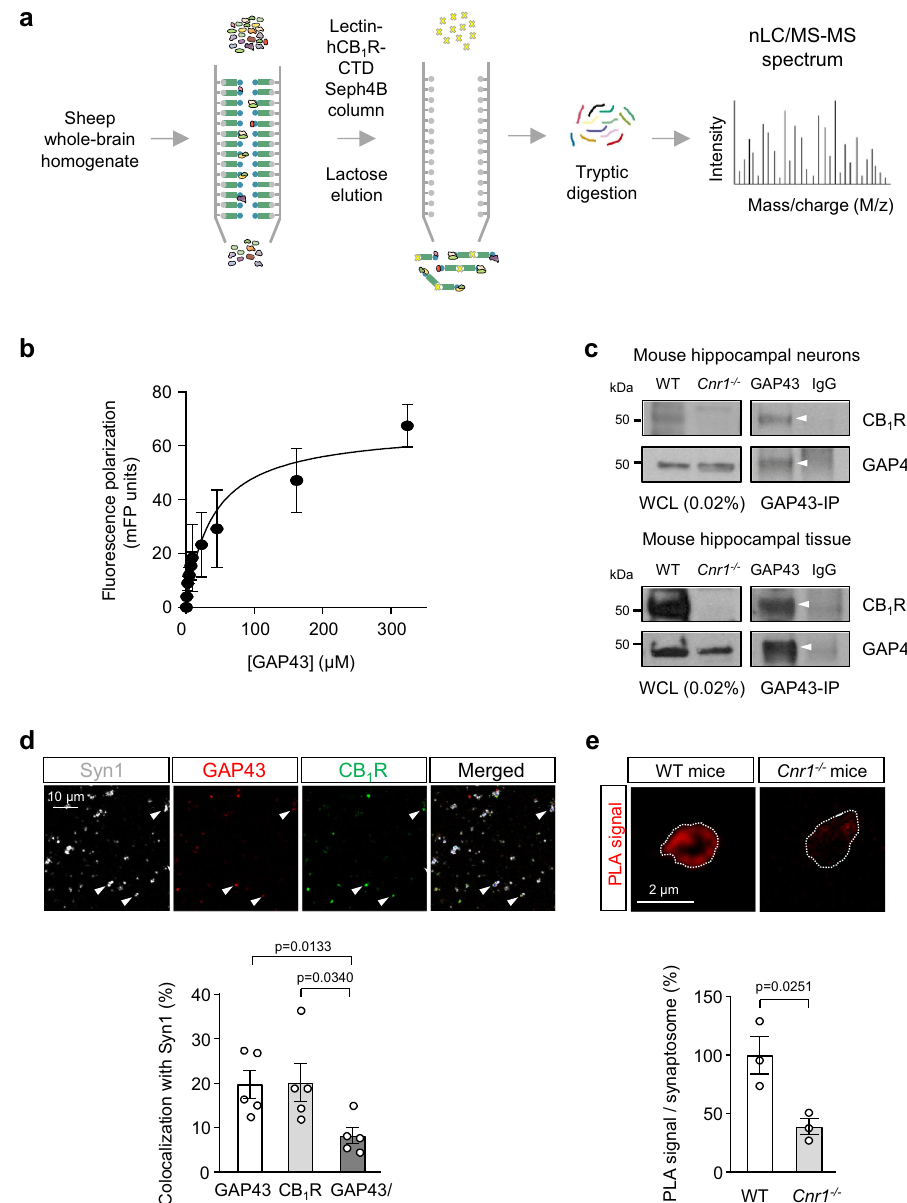
Fig. 1 | GAP43 interacts with CB1R. a Schematic work fl ow of the af fi nity pur- i fi cation and tandem MS/MS experiment conducted. A sheep whole-brain homo- genate was loaded onto a lectin-hCB 1 R-CTD-bound Sepharose 4B column. After washing, elution with lactose, eluted-fraction separation by SDS-PAGE, and diges- tion with trypsin, peptides were subjected to nLC/MS-MS proteomic analysis. b Fluorescencepolarization(FP)-basedprotein – proteinbindingexperimentsusing 5-IAF-labeled CB 1 R-CTD and increasing amounts of unlabeled GAP43. FP was expressedasmilli-FPunits.Eachpointrepresentsthemean±SEMof3independent experiments. c Co-immunoprecipitation experiments in (top) primary mouse hip- pocampal neurons or (bottom) mouse hippocampal tissue. Immunoprecipitation (IP) was conducted with anti-GAP43 antibody or control IgG. Arrowheads point to speci fi c precipitated bands. Whole-cell lysates (WCL) from 3-month-old WT and control Cnr1 − / − mice are shown. A representative experiment is shown. The